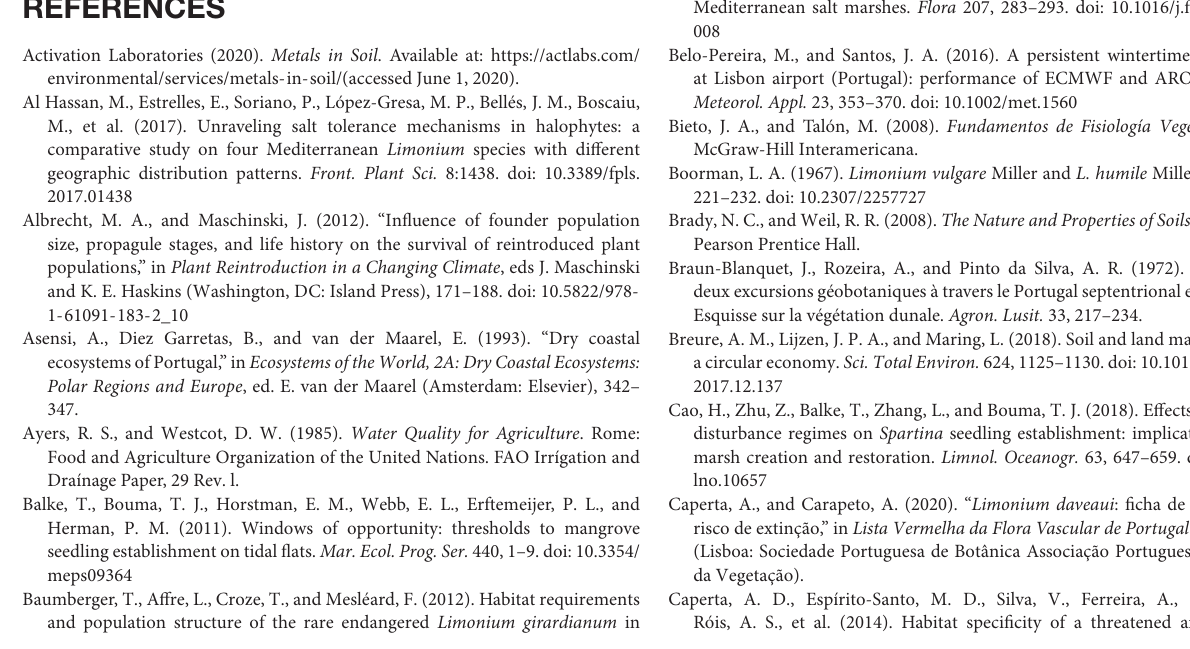
Supplementary Figure 1 | Physical appearance of Fluvisol (A) and Technosol (B) . The Fluvisol was collected in Sobralinho salt marsh area in the Municipal Council of Vila Franca de Xira, west Portugal. The Technosol was produced with Fluvisol and organic/inorganic wastes’ as amendments. Seed germination (white arrows) on a water film retained in the Fluvisol surface (C) and in the Technosol surface, where the water film was not present (D) . Supplementary Table 1 | Correlation matrix between the first two principal components (PC1 and PC2) on the normalized data and the original variables. This matrix includes the pH, CE, organic carbon (C) and nutrient concentration (N total (N), extractable P (P), extractable K (K), Fe, Mn, Zn, Cu) values determined in the substrata in the beginning of the assay (T0) and morphometric parameters (leaf number, leaf length, leaf width, scape number, scape length) and photosynthetic indexes (Normalised Difference Vegetation Index (NDVI) and Photochemical Reflectance Index (PRI)) obtained in plants at the end of the assay (T3). Supplementary Table 2 | Correlation matrix between variables. This matrix includes the pH, CE, organic carbon (C) and nutrient concentration (N total (N), extractable P (P), extractable K (K), Fe, Mn, Zn, Cu) values determined in the substrata in the beginning of the assay (T0) and morphometric parameters (leaf number, leaf length, leaf width, scape number, scape length) and photosynthetic indexes (Normalised Difference Vegetation Index (NDVI) and Photochemical Reflectance Index (PRI)) obtained in plants at the end of the assay